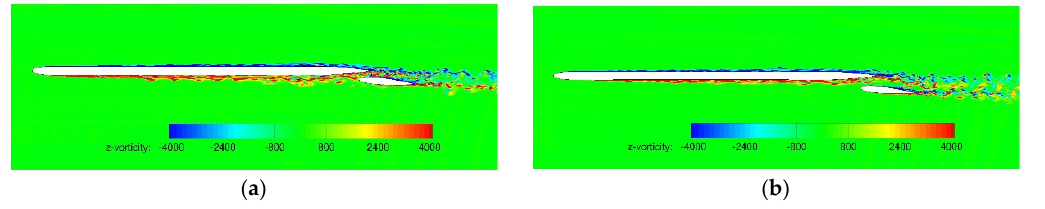
Figure 24. z-direction vorticity contours: ( a ) initial shape; ( b ) optimal shape.